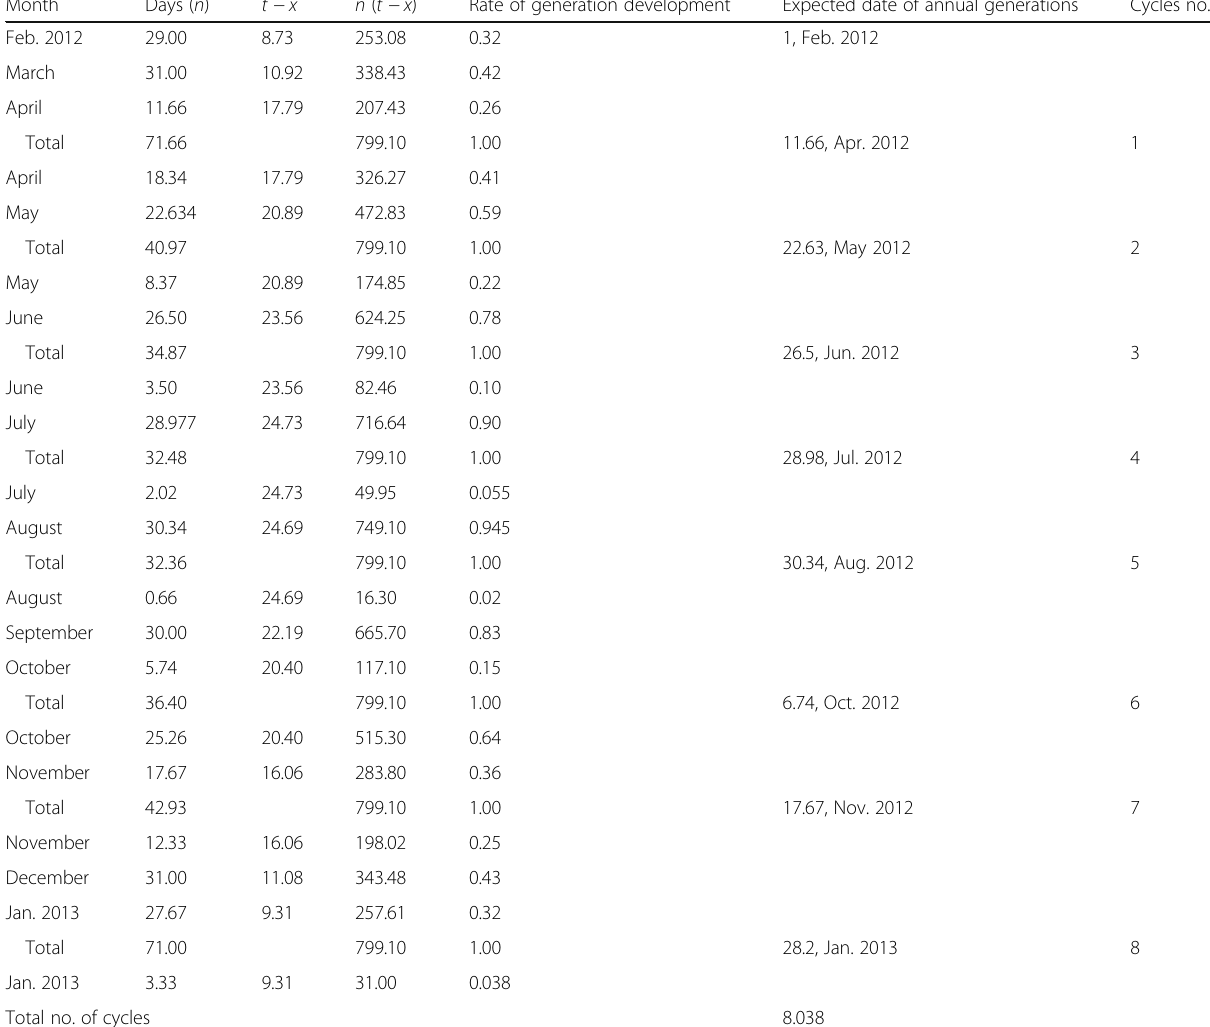
Table 3 Expected frequencies of annual generations of Tuta absoluta in Giza governorate during